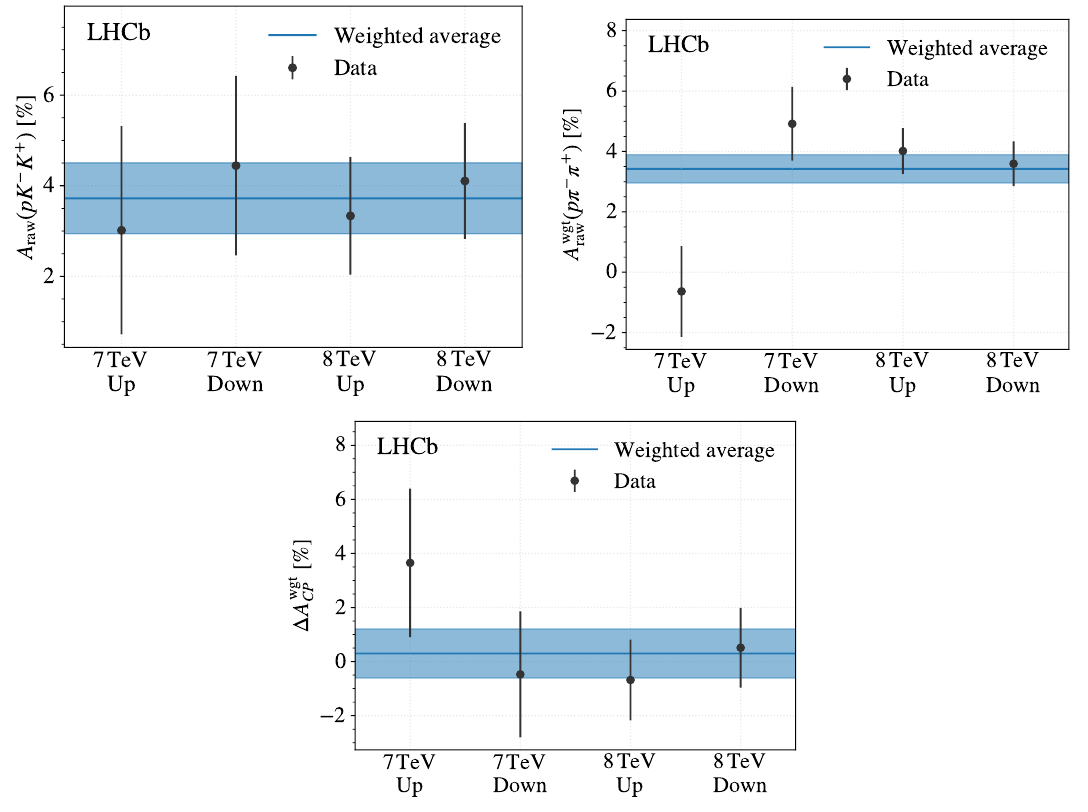
Figure 4 . Values of and statistical uncertainties on the asymmetries A raw ( pK (cid:0) K + ) (top left), A wgt ( p(cid:25) (cid:0) (cid:25) + ) (top right), and (cid:1) A wgt (bottom centre), for the four data subsamples (two centre- raw CP of-mass energies, 7 and 8 TeV, and two polarities of the dipole magnet, up and down). For each asymmetry, the average of the four data points, as described in the text, is also shown, where the band indicates the